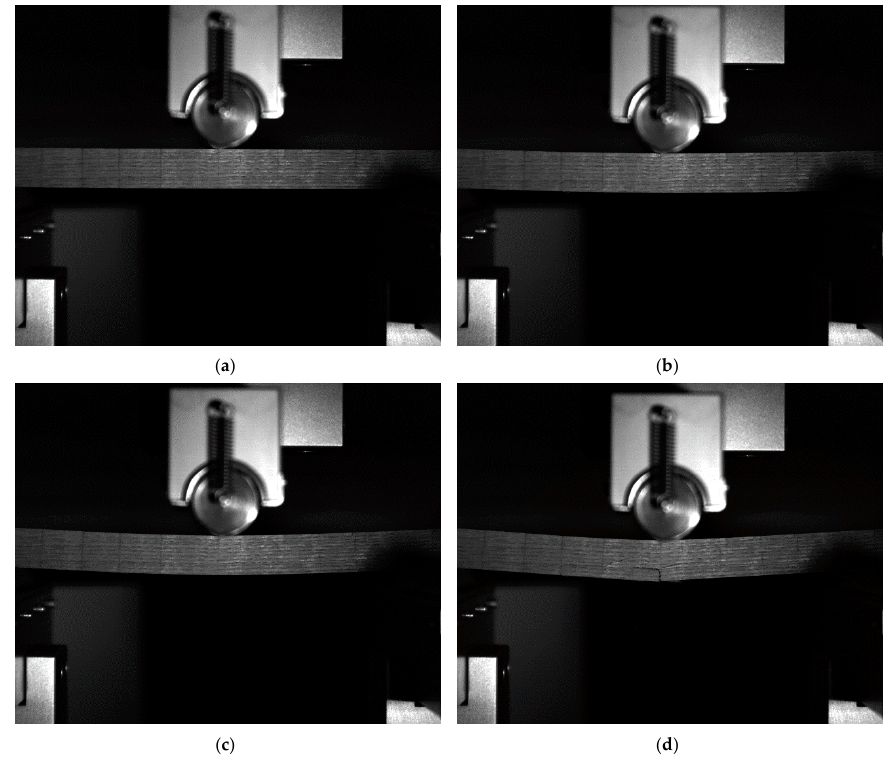
Figure 9. Time course of bending strength test for oak wood: 0 s ( a ), 30 s ( b ), 60 s ( c ) and 90 s ( d ).